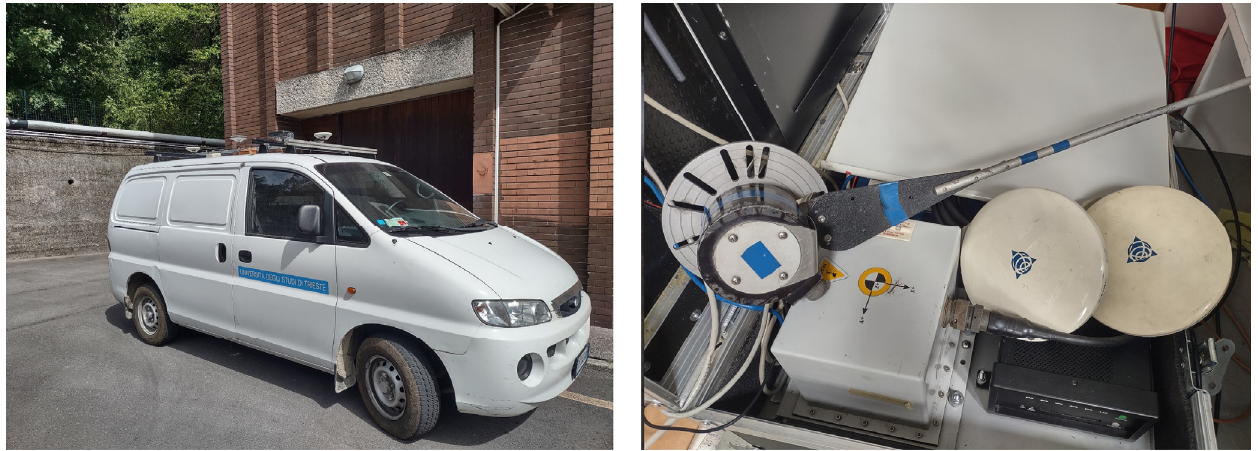
Figure 5. The MMS of the GeoSNav Lab, University of Trieste, and the Applanix Corporation POS/LV© system components mounted on board the vehicle. MMS data were used to create the reference trajectory. Table 6. Equipment used in the terrestrial data-collection campaigns.